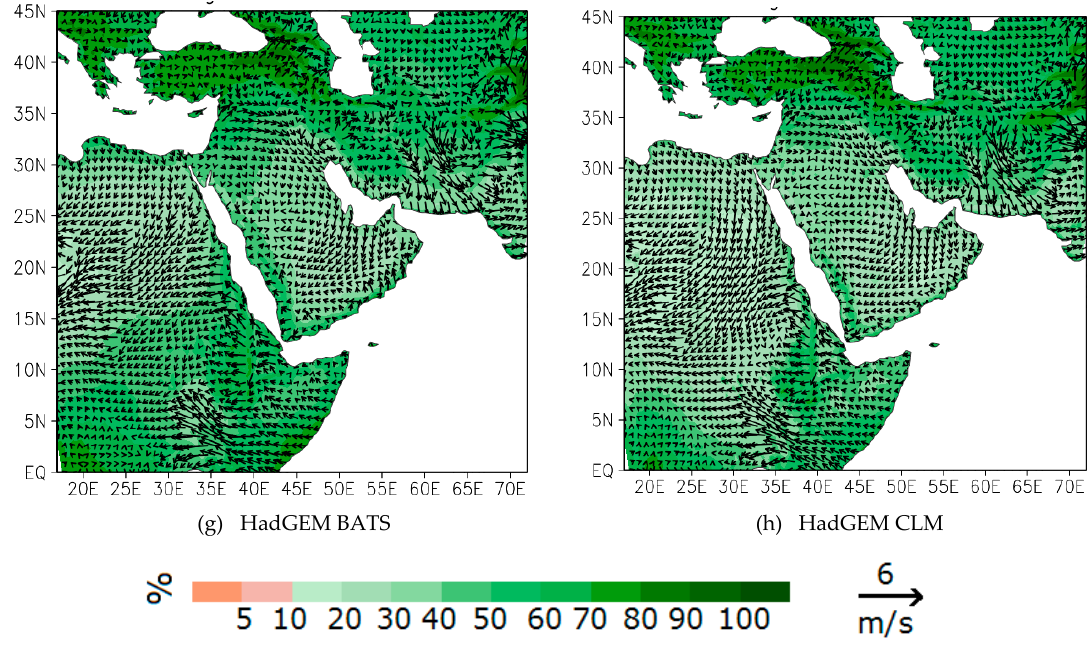
Figure 15. Spatial distribution of the wind vector (m/s) and relative humidity (%) for ( a ) ERA – Int BATS, ( b ) ERA – Int CLM, ( c ) ECHAM6 BATS, ( d ) ECHAM6 CLM, ( e ) GFDL BATS, ( f ) GFDL CLM,